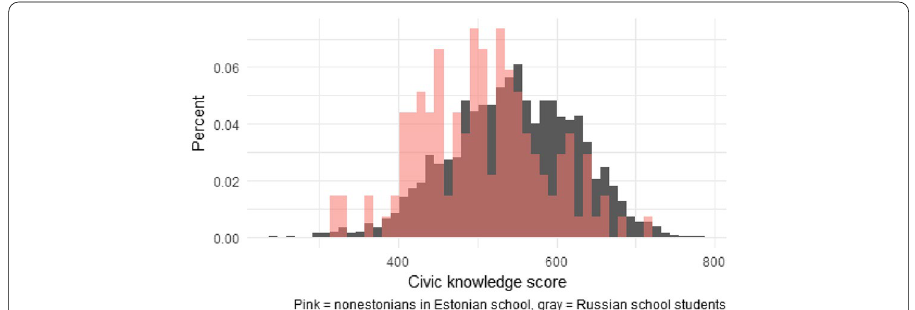
Fig. 6 Distributional properties of the subset non-Estonians in Estonian school and Russian school